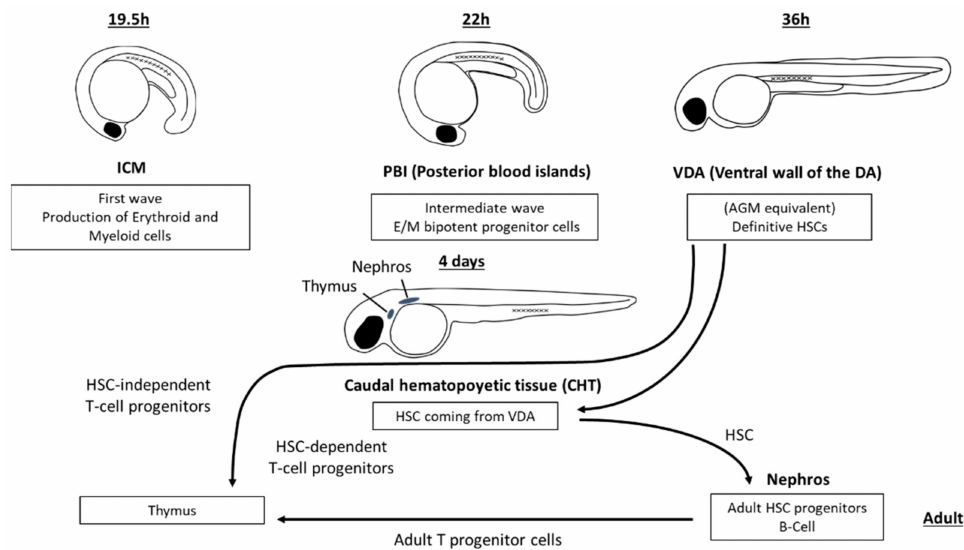
Figure 1. Lympho-hematopoietic sites in the developing zebrafish. First haemopoietic loci include ICM (Intercellular mass), PBI (posterior blood islands) and VDA (ventral wall of the dorsal aorta). From this last region, definitive HSC (hematopoietic stem cells) colonize the caudal hematopoietic tissue (CHT), and both HSC-independent and HSC-dependent T cell progenitors seed into the thymic primordium. From CHT, progenitor cells colonize the nephros that is the main hematopoietic organ of adult